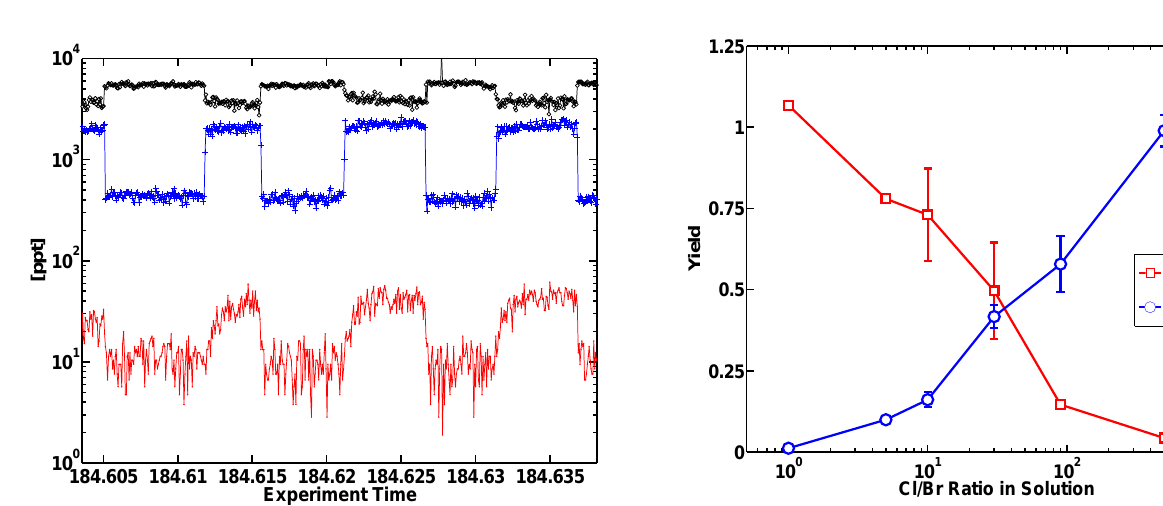
Fig. 2. An example experimental time series showing calibrated ion signals in mixing ratio units (pptv) during which a halide-doped ice surface was repeatedly exposed to N 2 O 5 . N 2 O 5 signal (black circles), is high when it is bypassing the ice surface, and lower during exposure. Upon exposing the ice surface to N 2 O 5 , halo- genated species including ClNO 2 (blue crosses), and Br 2 (red line) are promptly produced with a total halogen yield per N 2 O 5 reacted near unity.